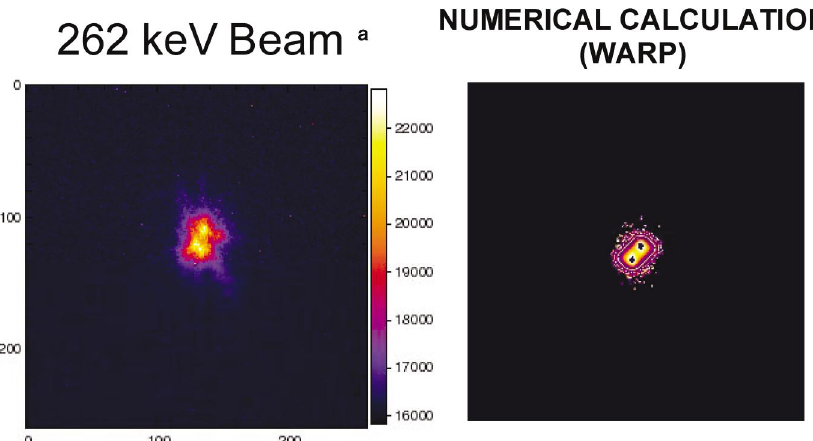
FIG. 15. (Color) Analog (pinhole) simulation and WARP3D calculation of fully neutralized beam focused to a small spot. Image box size is 4 cm b (cid:12) 4 cm squares.